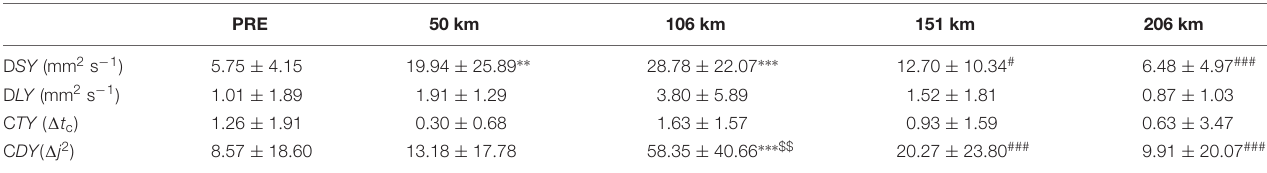
TABLE 2 | Results of SDA Parameters in the AP plan with short term effective diffusion coefficient (D sy ), long term effective diffusion coefficient (D ly ), critical point (C t, C d ) during the condition PRE and every 50 km.